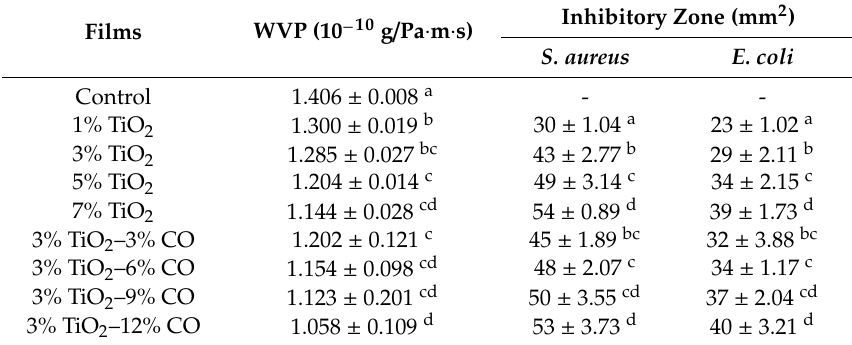
Table 2. Water vapour permeability (WVP) and antimicrobial properties.